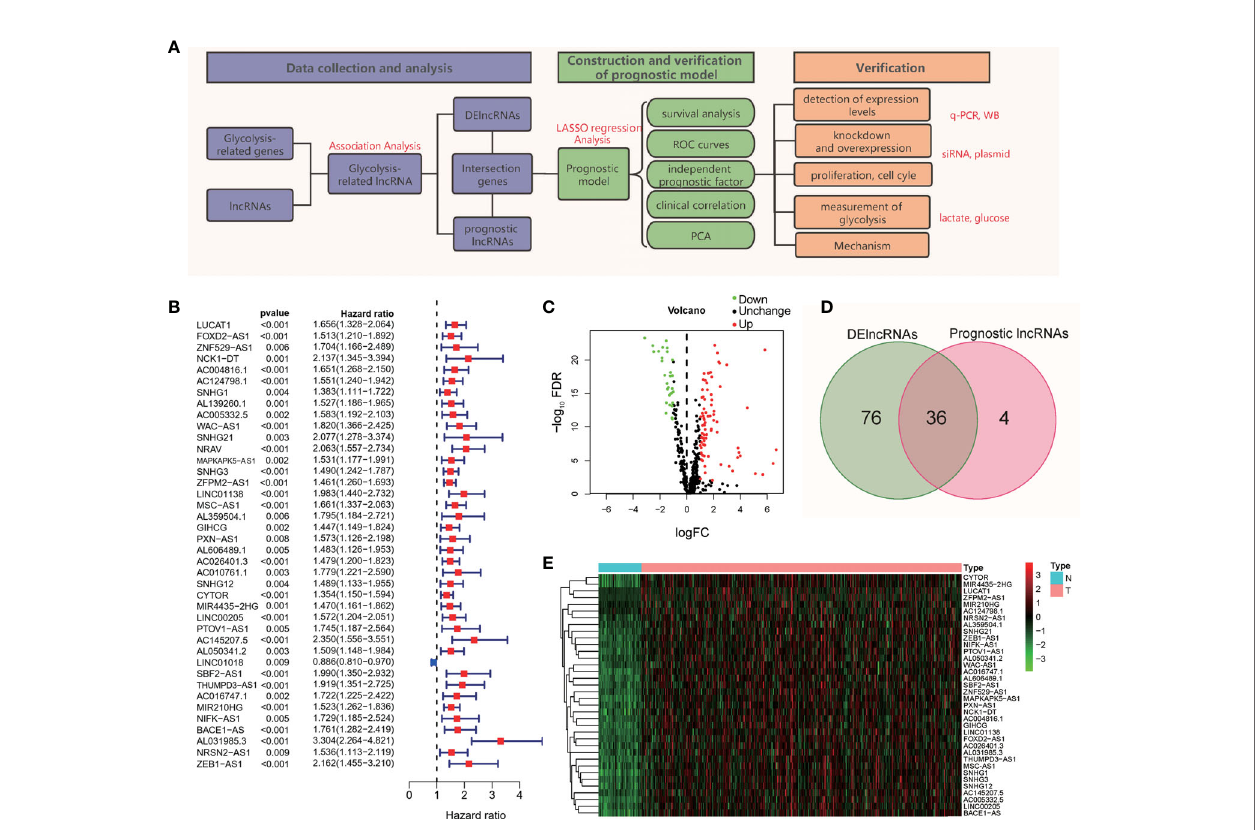
FIGURE 1 | Flowchart and lncRNA screening process. (A) Flowchart of the study. (B) Forest plot of univariate Cox regression analysis; (C) Volcano map of differentially expressed genes; (D) Intersection of DE lncRNAs and prognostic lncRNAs; (E) Heatmap of the 36 intersecting